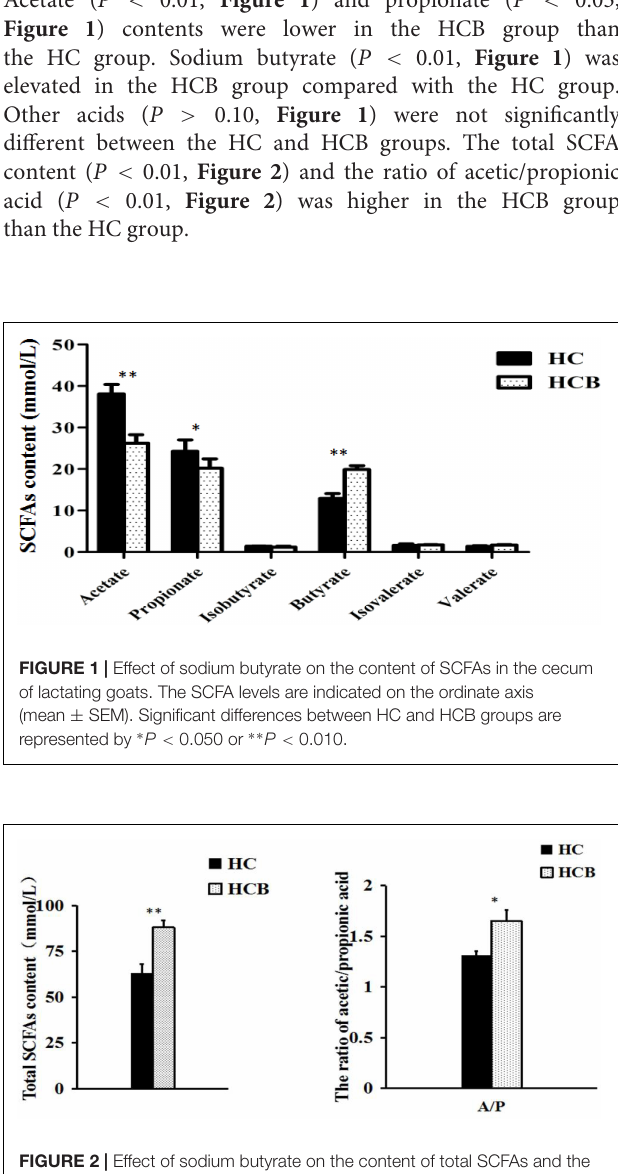
FIGURE 2 | Effect of sodium butyrate on the content of total SCFAs and the ratio of acetic/propionic acid in the cecum of lactating goats. The data from both groups are indicated on the ordinate axis (mean ± SEM). Significant differences between HC and HCB groups are represented by ∗ P < 0.050 or ∗∗ P <